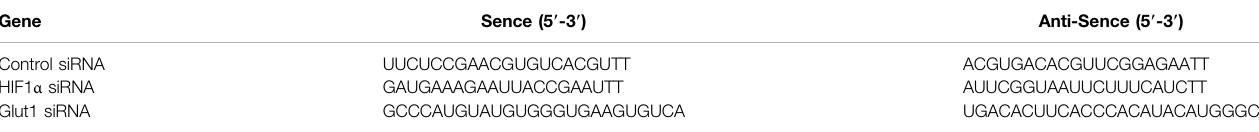
TABLE 1 | siRNA sequences used in the study. Gene